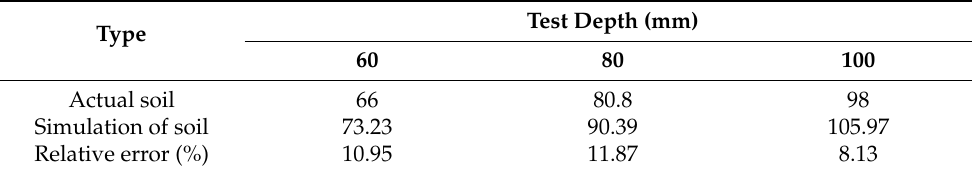
Table 3. Comparison of soil compactness.